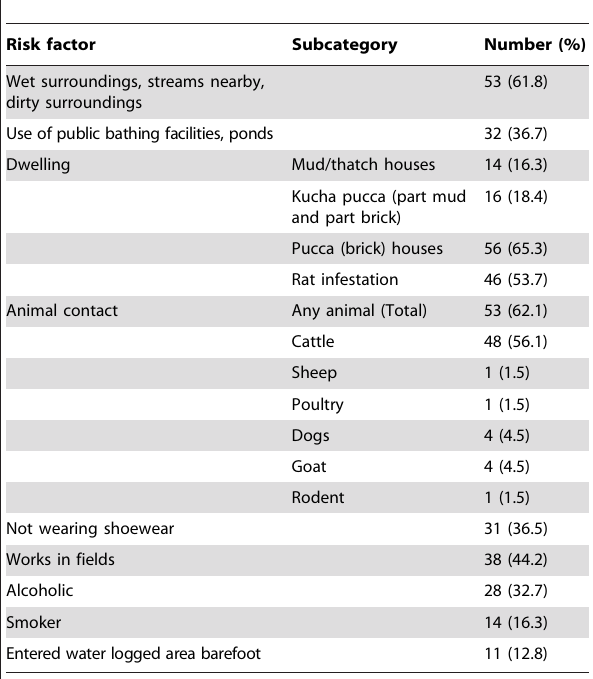
Table 4. Clinical features of 86 leptospirosis patients.